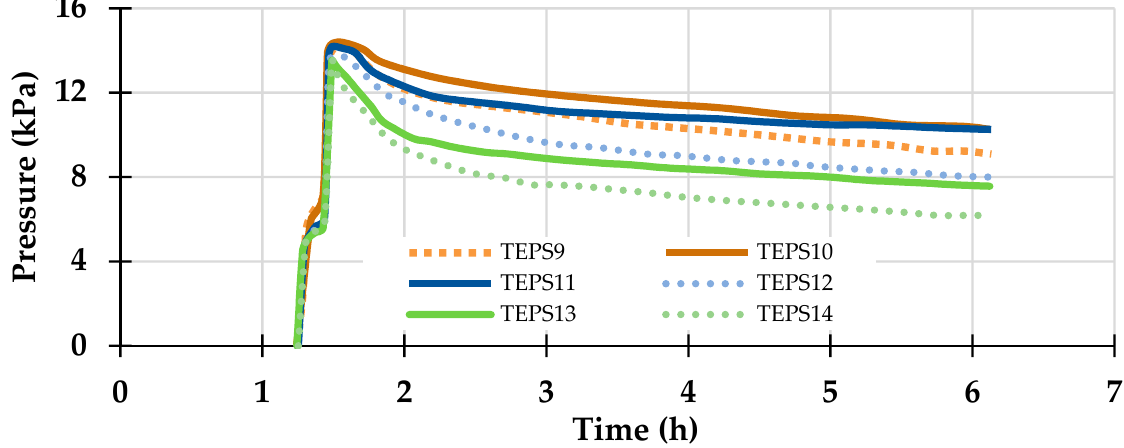
Figure 11. The backfill pressure measurement on the upstream side of the barricade .